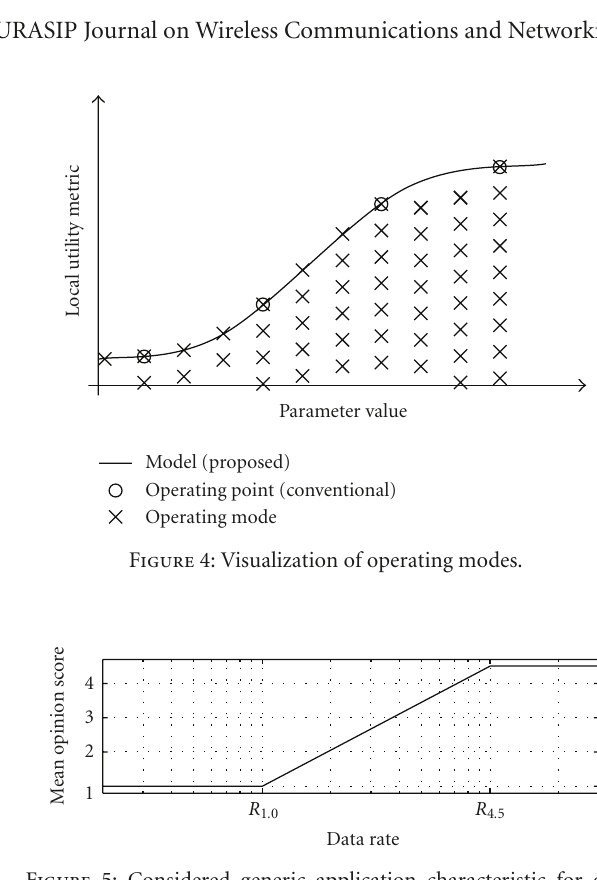
Figure 5: Considered generic application characteristic for one example application